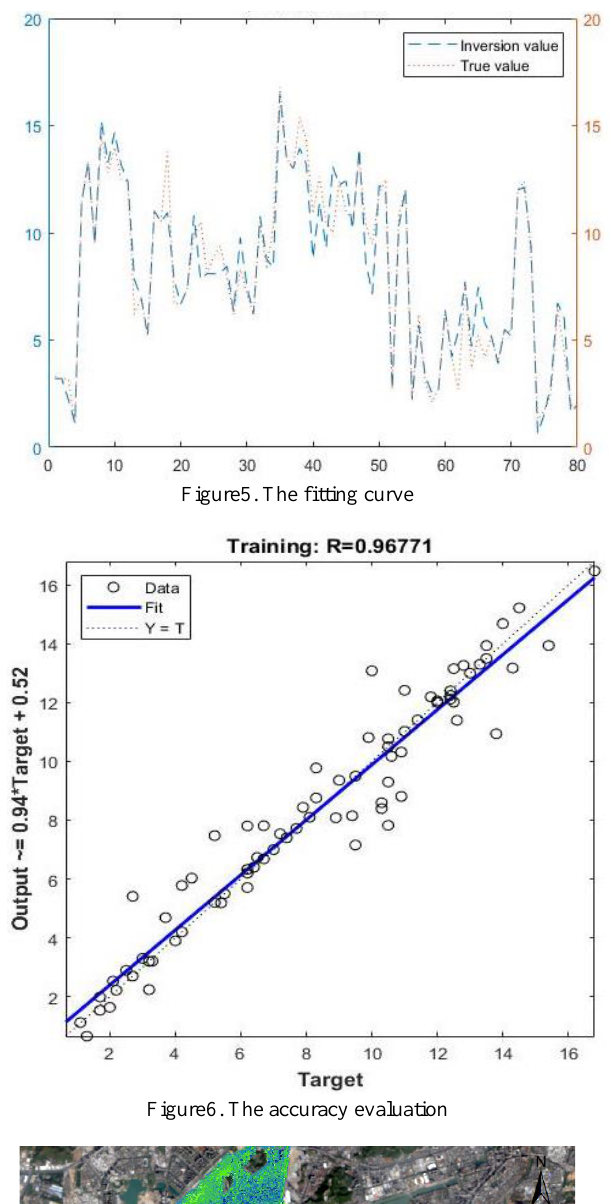
Figure5. The fitting curve